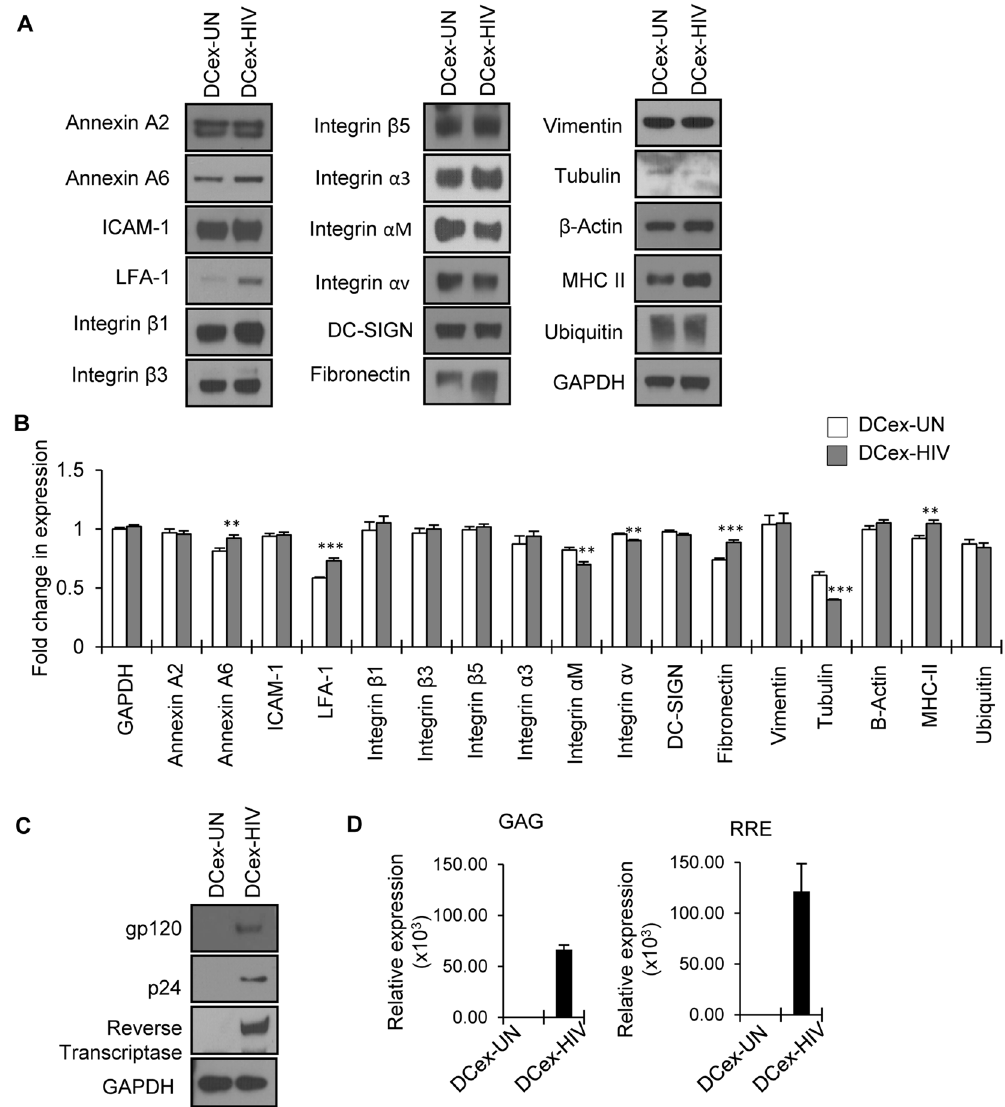
Figure 3. Molecular analysis of exosomes from uninfected and HIV-1 infected DCs (DCex-UN and DCex- HIV). ( A ) Representative Western blot images showing expression of indicated proteins in the lysates (10 µ g) of exosomes derived from uninfected (DCex-UN) or HIV-1 infected (DCex-HIV) DCs. GAPDH served as a loading control. ( B ) Quantitative analysis of Western blot images of ( A ); the band intensity of each lane was determined by Image J software and pixel density was calculated. Fold change was determined by considering band intensity of GAPDH in untreated cells as 1 ( ** p ≤ 0.01, *** p ≤ 0.001, p-values for Annexin A6 – 0.00645, LFA-1 – 0.00047, Integrin α M – 0.00269, Integrin α v – 0.00112, Fibronectin – 0.00051, Tubulin – 0.00028, MHC-II – 0.00408. ( C ) Representative Western blot images showing expression of HIV-1 proteins in the lysates of exosomes derived from uninfected or HIV-1 infected DCs. GAPDH was used as a loading control. Full- length blots are presented in Supplementary Figure S3. ( D ) Total RNA was isolated from exosomes derived from uninfected (DCex-UN) or HIV-1 infected (DCex-HIV) DCs and analyzed for the expression HIV-1 genes by qRT-PCR. The data represents mean of triplicates ± SE from three independent